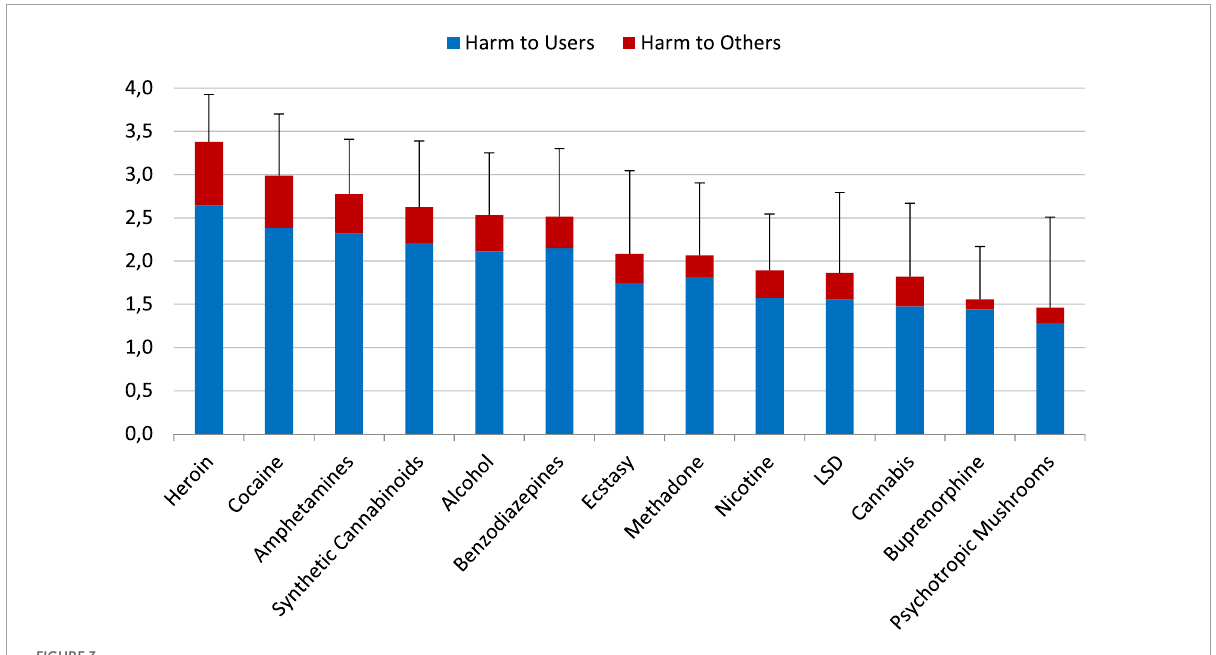
FIGURE3 Average overall harm of the evaluated 13 substances (mean values and standard deviations) as assessed by the user cohort 1 on a scale from 0 (“not harmful”) to 4 (“extremely harmful”), shown as harmful to users and harmful to others. The relative contribution of the 5 dimensions ( Supplementary Figure 1 ; Table 1 ) had been weighted by user cohort 2. Especially valid were the ranks of the core group of substances: nicotine, cannabis, cocaine, alcohol, heroin, methadone, and amphetamines (see Data analysis and statistics). Supplementary Figure 17 shows also the results for the excluded substances.